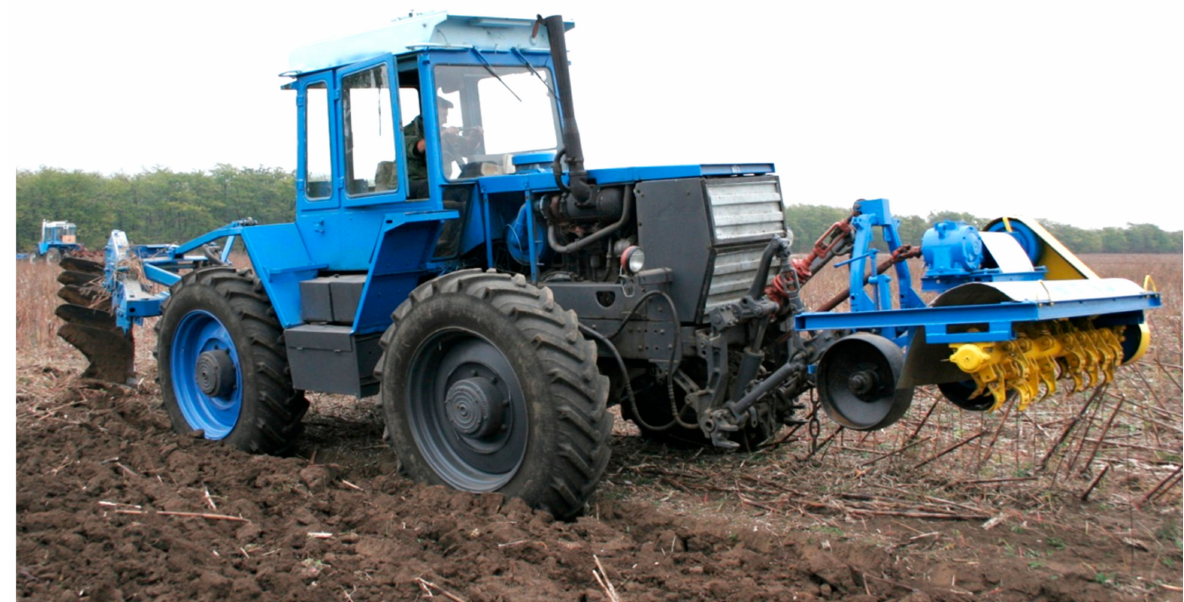
Figure 1. Plow-chopping